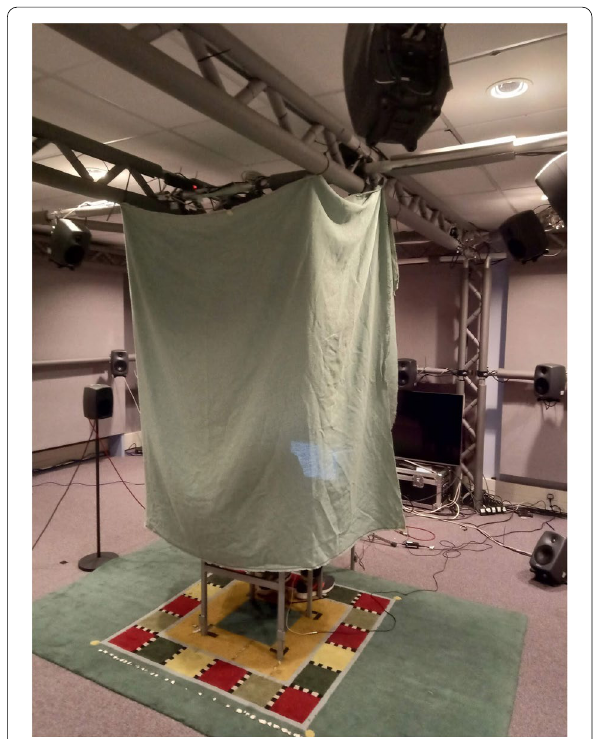
Fig. 1 Presentation of the VSE stimuli to the listener in the